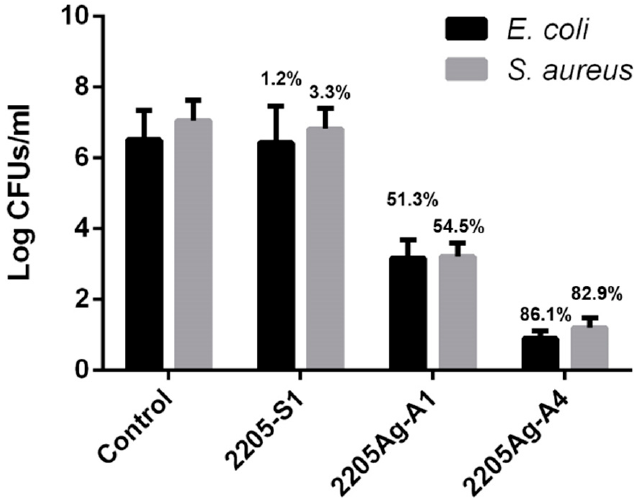
Figure 5. Standard plate count of bacteria (CFU) and the corresponding antibacterial properties (%) of the 2205-S1, 2205Ag-A1, and 2205Ag-A4 specimens against Escherichia coli and Staphylococcus aureus .